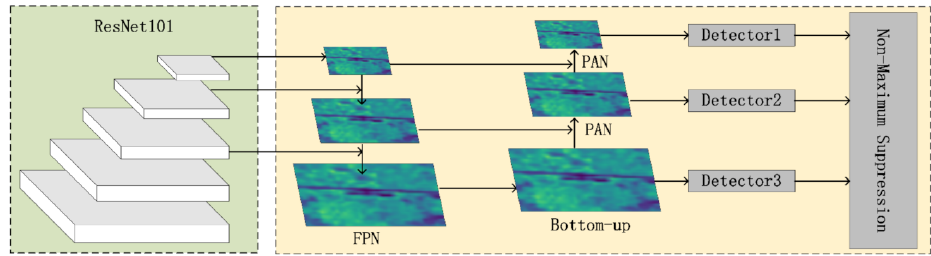
Figure 3. The Feature Fusion Network used for feature transfer containing two parts: the FPN and the Bottom-up